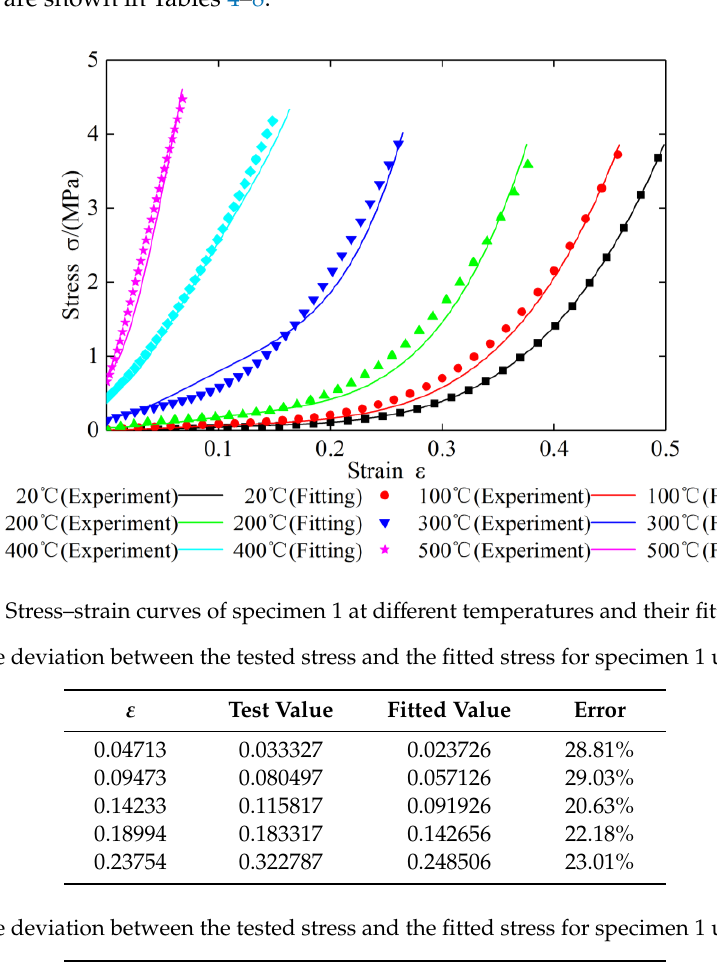
Figure 16. Stress – strain curves of three specimens at different temperatures and their fitting curves.